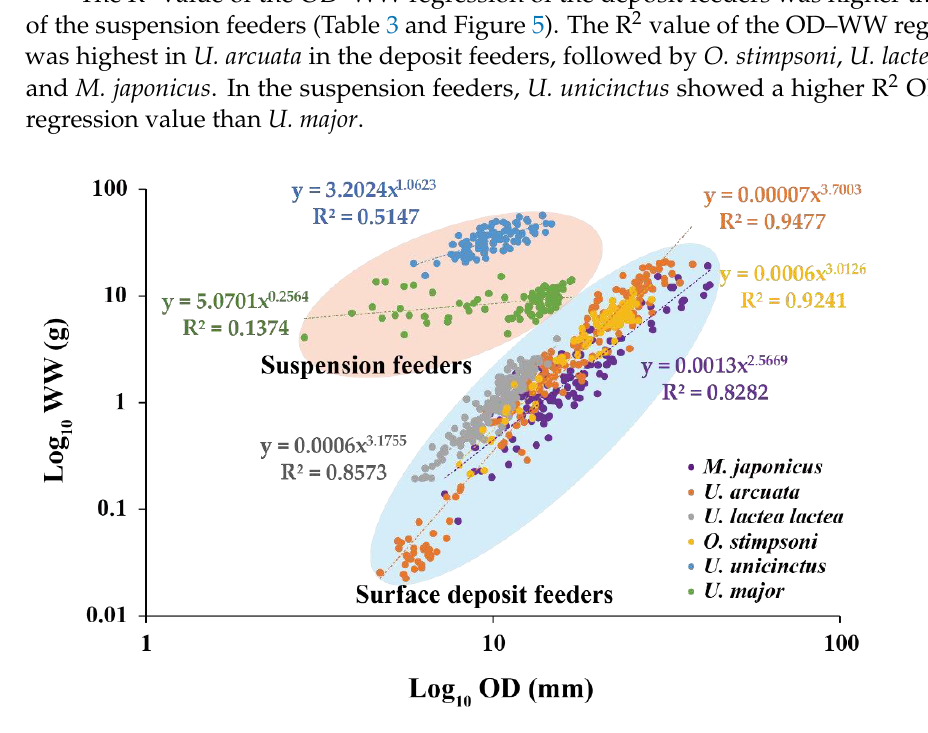
Figure 5. Comparison of the OD-WW relationship between surface deposit feeders and suspension feeders.